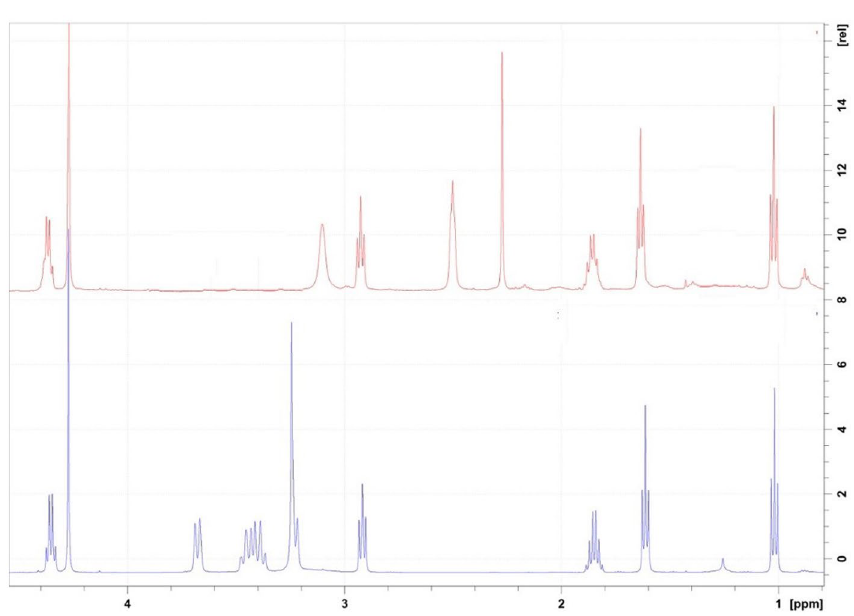
Figure 5. 1 H NMR major differences between Sildenafil (Upper Red) and Sildenafil N-oxide (lower